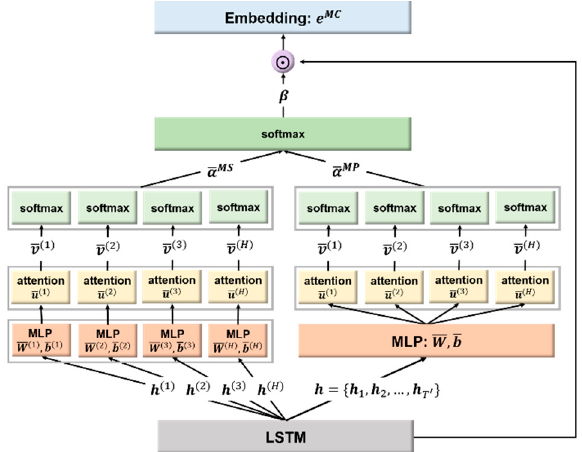
Figure 4. Block diagram of the proposed embedding extraction by combination of the projection and split multi-head attentions; the embedding e MC is obtained using the new attention weight β which is generated with combination of α MS and α MP . The attention layer output v ( i ) is calculated with the trainable parameters W , b and u .